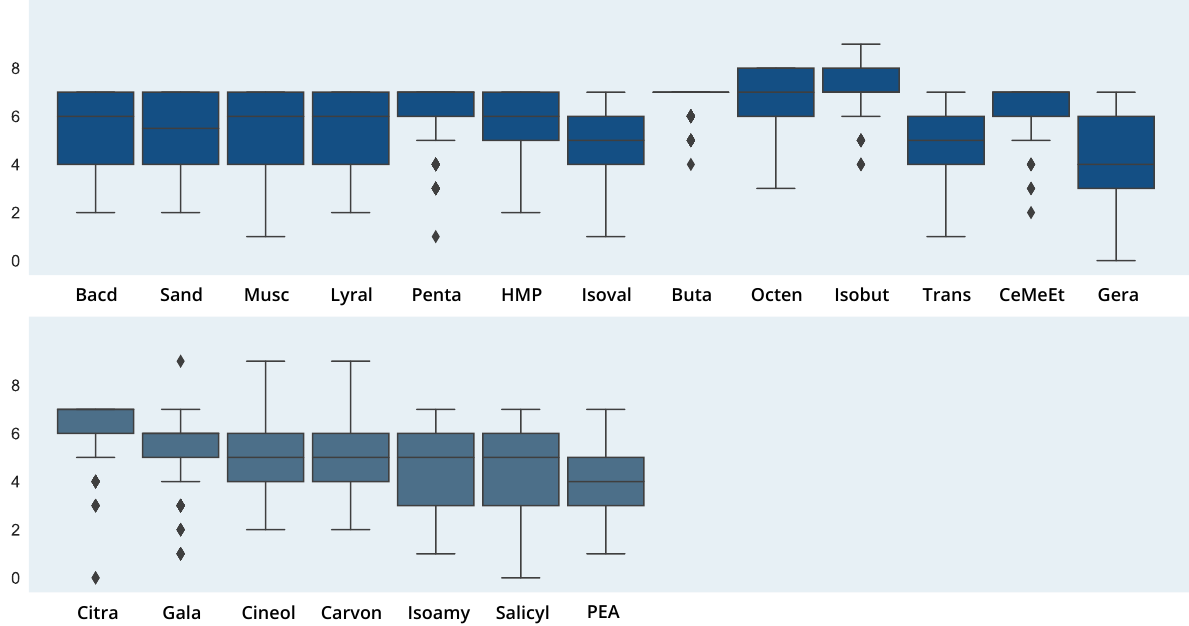
Figure 5. Detection Threshold. The figure shows boxplots for detection thresholds (dilutions from 0 = 1:10 0 to 9 = 1:10 9 ) of different odor molecules. Rhombs display